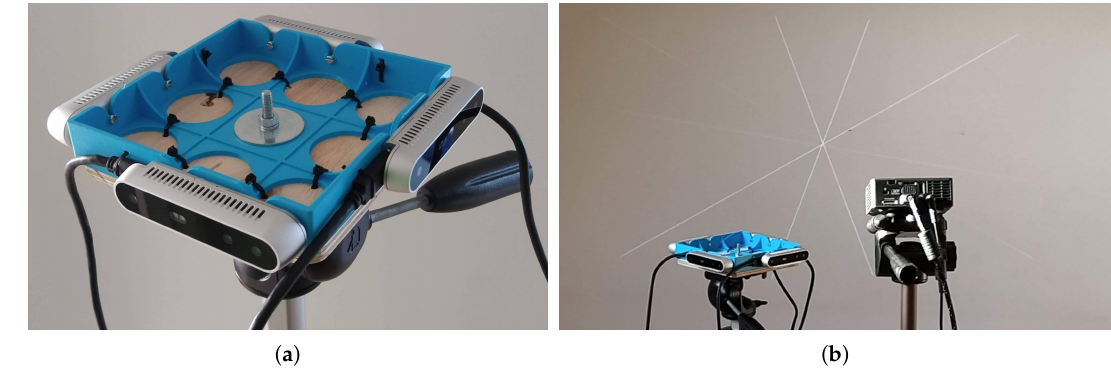
Figure 13. ( a ) The 360° camera setup with four Intel RealSense D415 cameras. ( b ) The complete measurement setup with cameras, projector, and projected